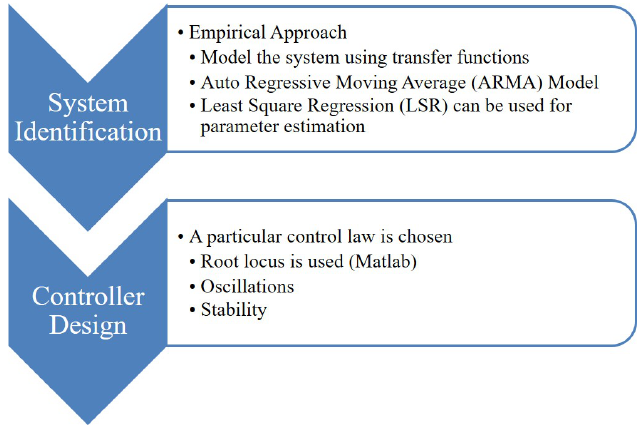
Figure 3. Classical control theory design.